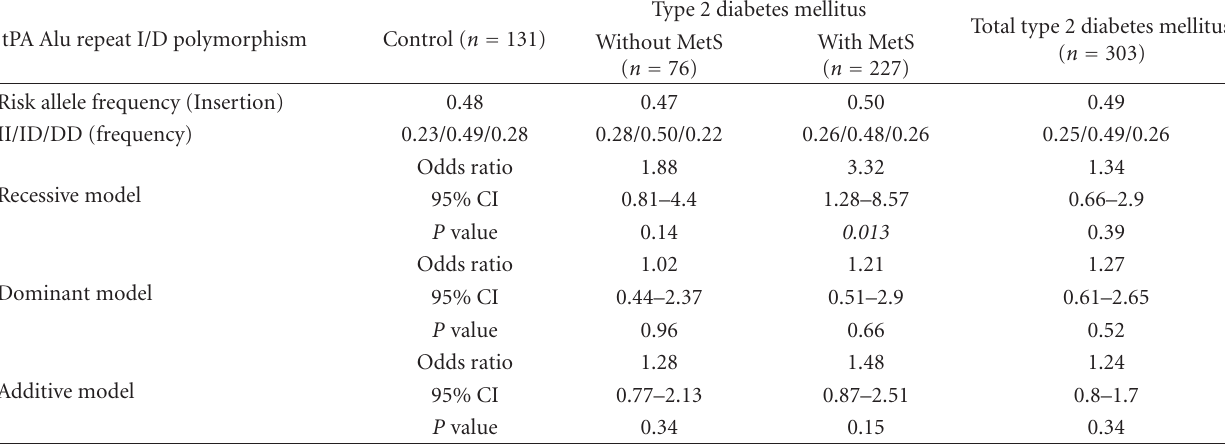
Table 3: Association of tPA Alu repeat-I/D polymorphism with type 2 diabetes mellitus in Malaysian